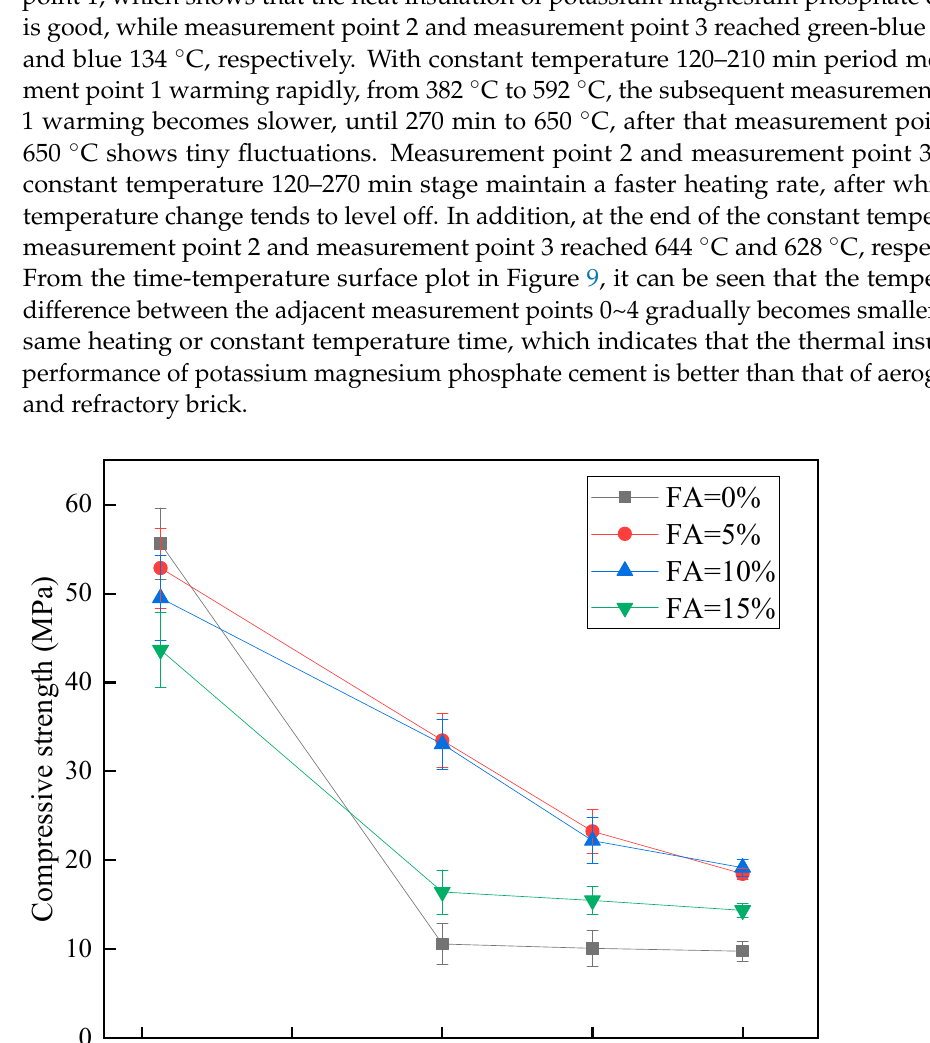
Table 4. Compressive strength of 28 d specimens with M:P of 2:1 after high temperature overheat ‐ ing (unit: MPa).